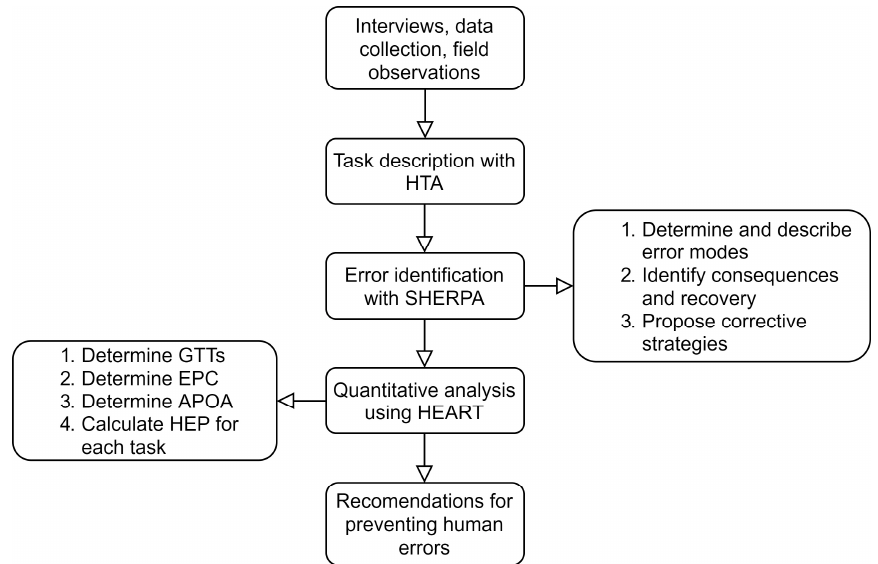
Figure 2. Human error analysis process used in the study. HTA = hierarchical task analysis; SHERPA = systematic human error reduction and prediction approach; HEART = human error assessment and reduction technique; GTT = generic task type, EPC = error producing condition; APOA = assessed proportion of effect; HEP = human error probability.